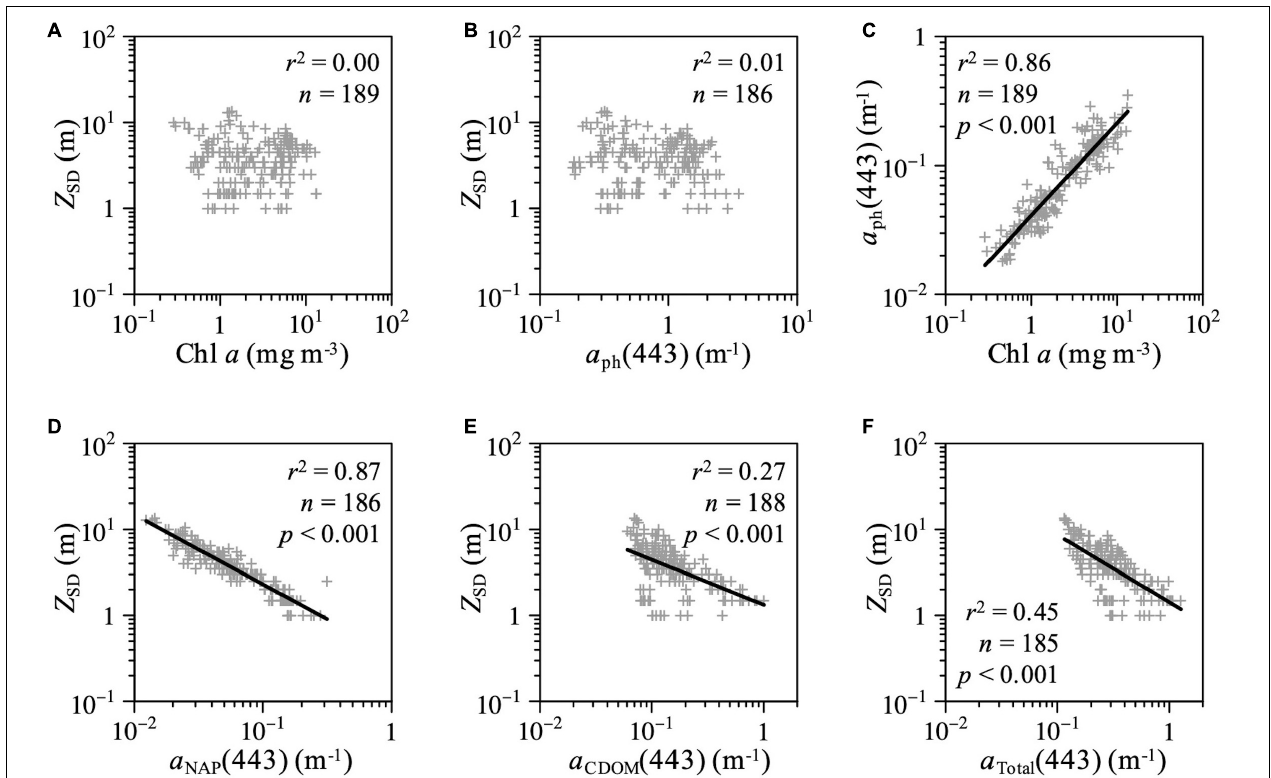
FIGURE 8 | Scatterplots of Z SD as a function of (A) Chl a concentration, (B) a ph (443), (D) a NAP (443), (E) a CDOM (443), and (F) total absorption coefficient at 443 nm in AB. (C) Scatterplots of Chl a concentration versus a ph (443) in